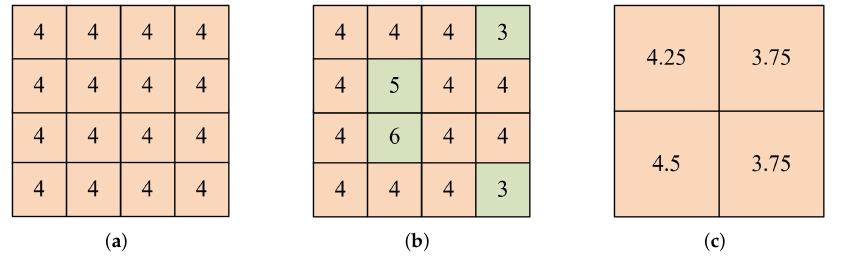
Figure 1. Average-down sampling. ( a ) Ideal image. ( b ) Images with noise. ( c ) Image downsampled by the averaging method.